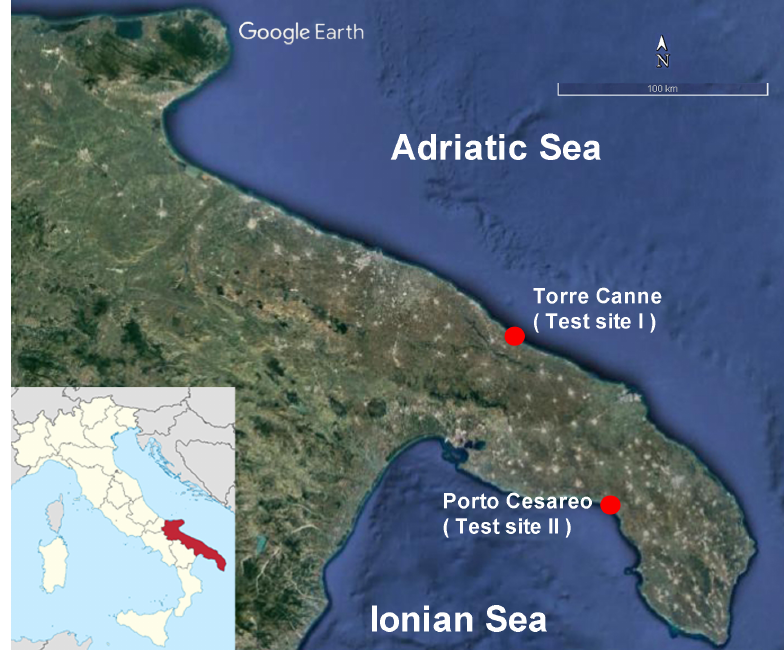
Figure 2. Selected test sites: Torre Canne and Porto Cesareo, both located in Southern Italy. The optical image is from